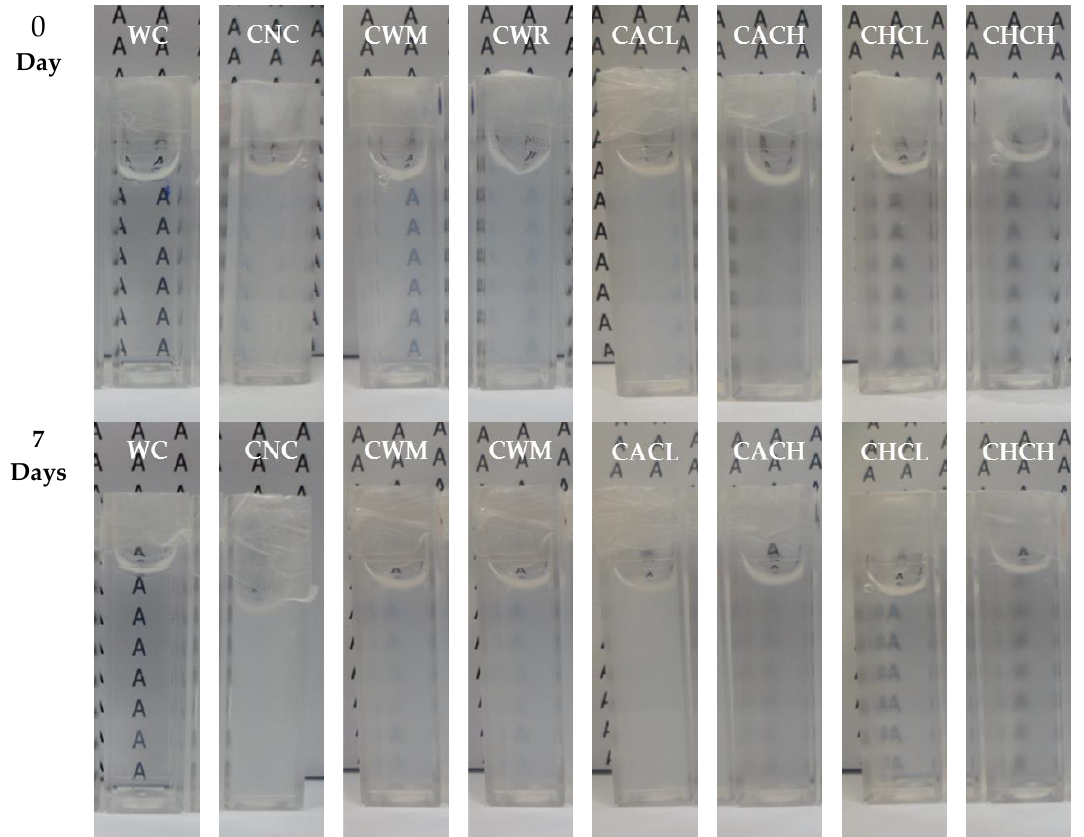
Figure 6. Appearance of 2% starch pastes from Thai non-GM bred waxy cassava starch (WC), commercial normal cassava starch (CNC), commercial waxy maize starch (CWM), commercial waxy rice starch (CWR) and commercial acetylated cassava starches with low and high degrees of substitutions (CACL and CACH) and commercial hydroxypropylated cassava starches with low and high degrees of molar substitutions (CHCL and CHCH) before and after storage at 4 ℃ for 7 days.